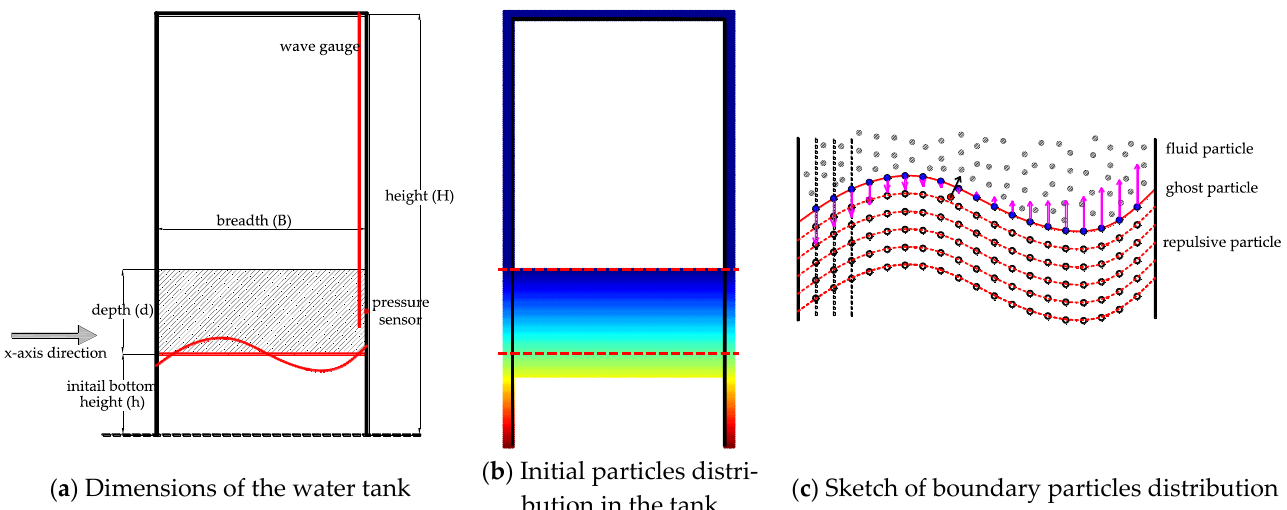
Figure 14. Configuration of the water tank: ( a ) Dimensions of the water tank; ( b ) Initial particles distribution in the tank; ( c ) Sketch of boundary particles distribution.